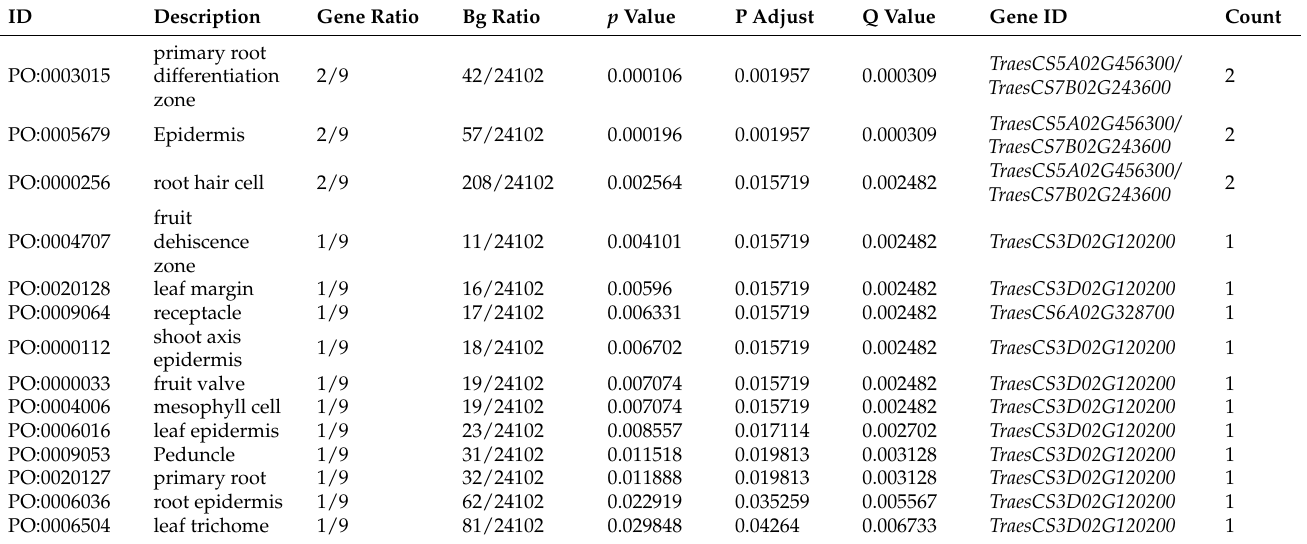
Table 5. Plant ontology created using the reference annotation of Arabidopsis thaliana and Zea mays genomes. For this purpose, drought protein sequences were checked for homology across the available annotated sequences. Majority of homologs were found and plant ontology annotations were assigned to wheat sequences as given